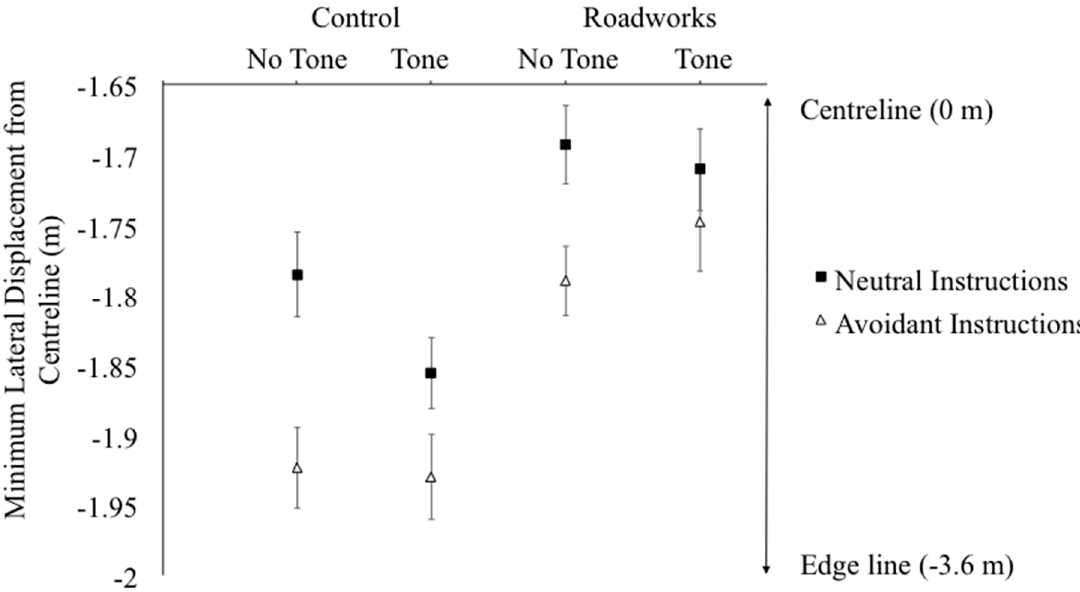
Figure 2. Minimum distance from the centreline (m) across the experimental conditions: instructions that were neutral or avoidant, secondary task (tone counting was present or absent), and driving difficulty (with or without roadworks).